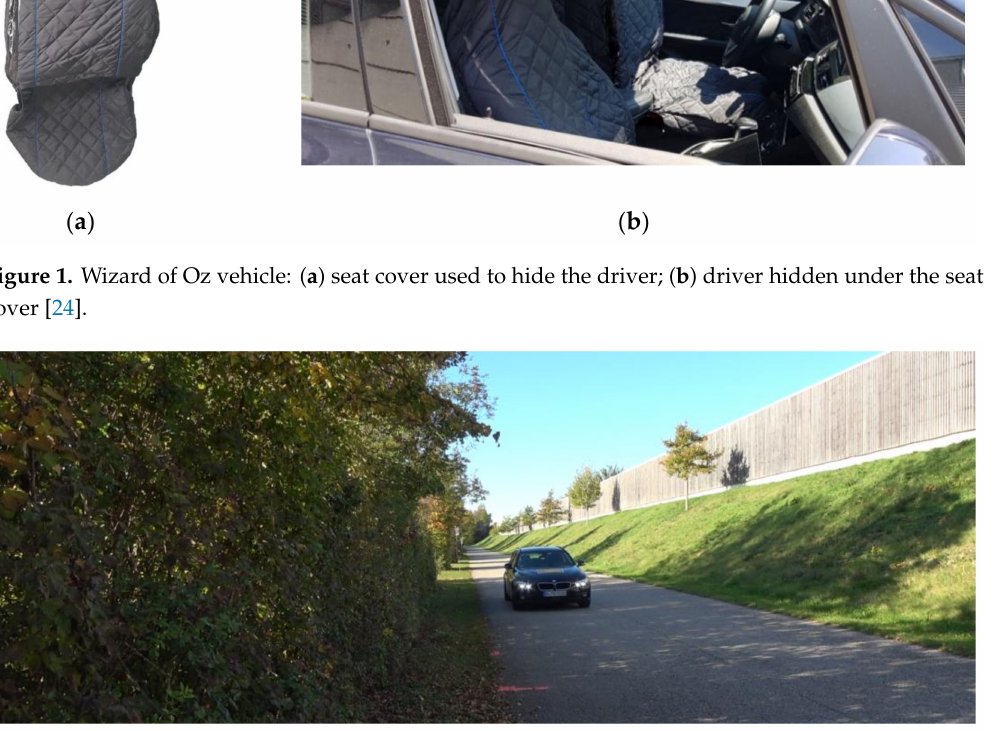
Figure 2. Wizard of Oz setup.